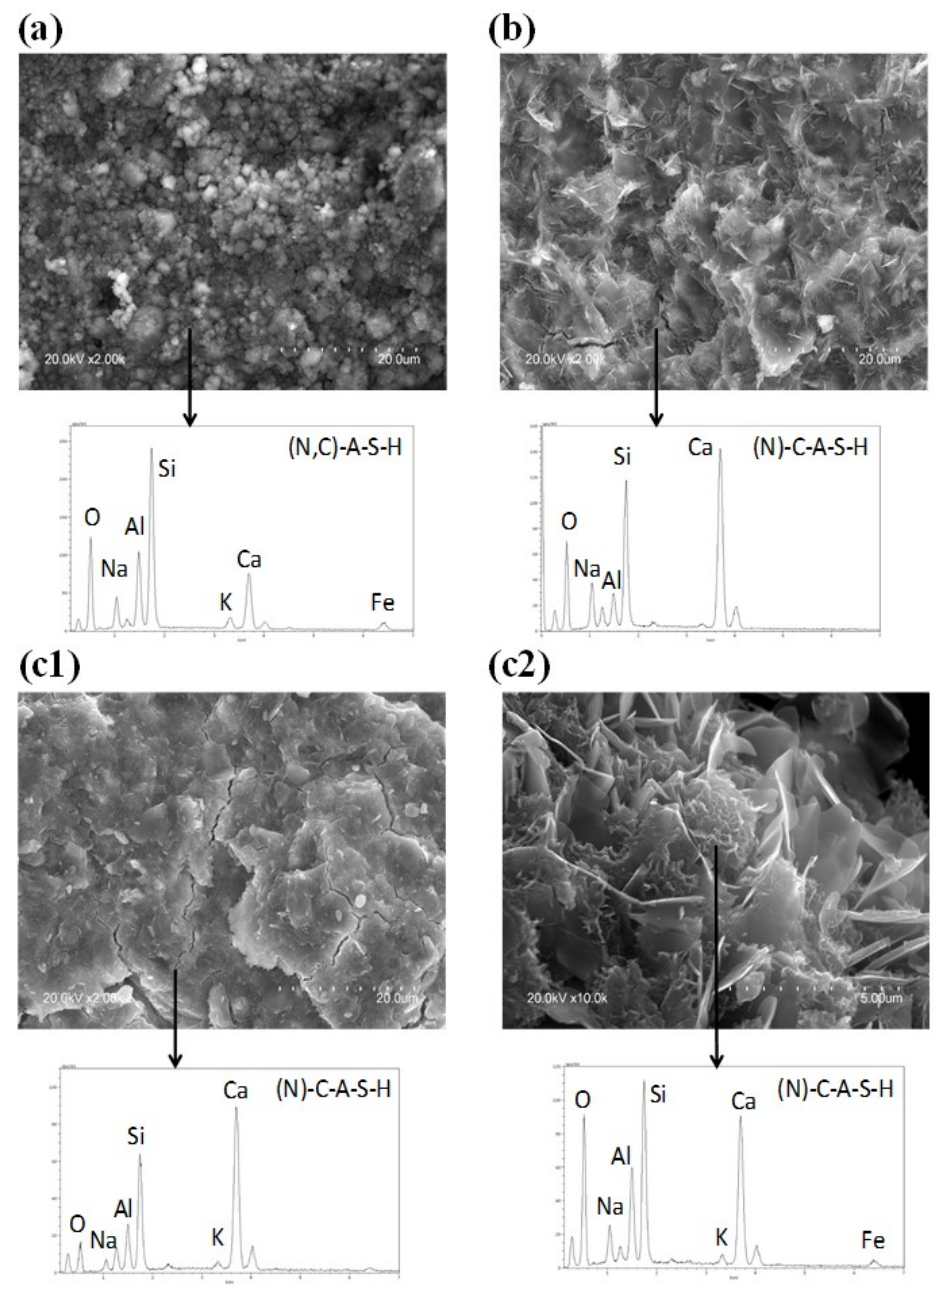
Figure 6. SEM micrographs and EDS spectra of ( a ) MA57_4M, ( b ) BFSS_4M, and ( c1 ) MA57S_4M after 28 days and ( c2 ) high magnification image of c1. Scale bar and magnification are shown in the image.